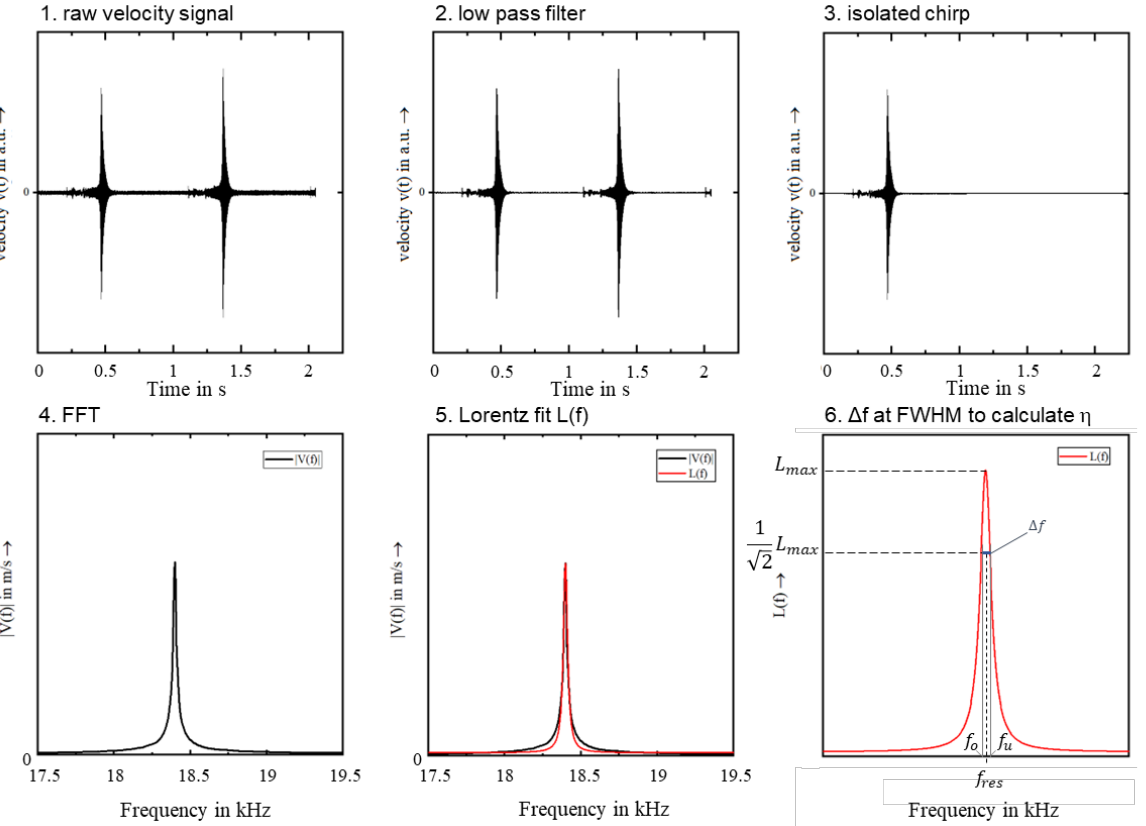
Figure 4. Schematic evaluation procedure for the measurement of the loss factor by FWHM-method chronologically from 1 to 6 .